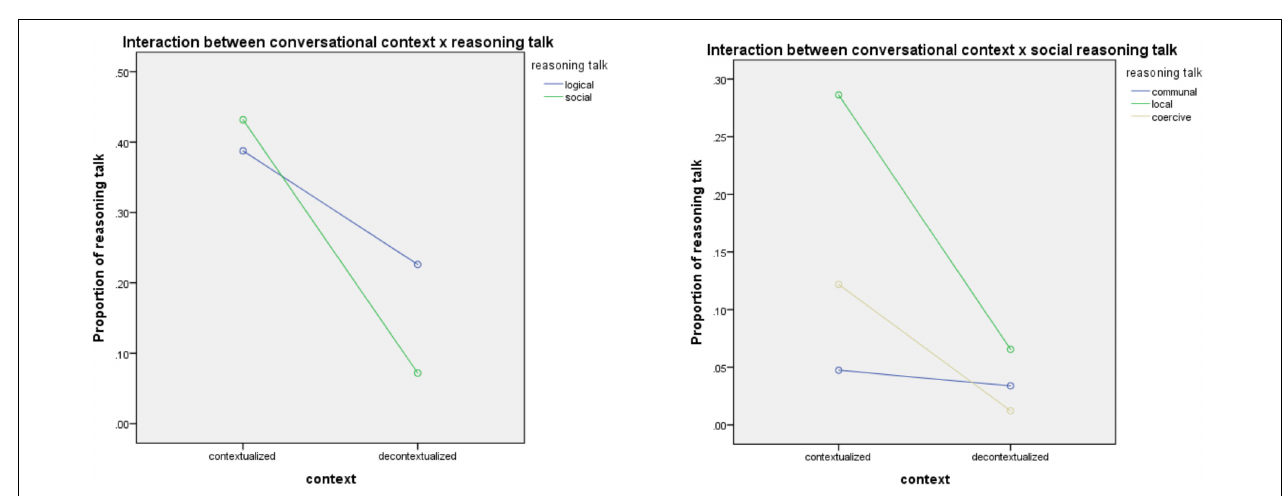
FIGURE 1 | The interaction between family members × types of reasoning talk.